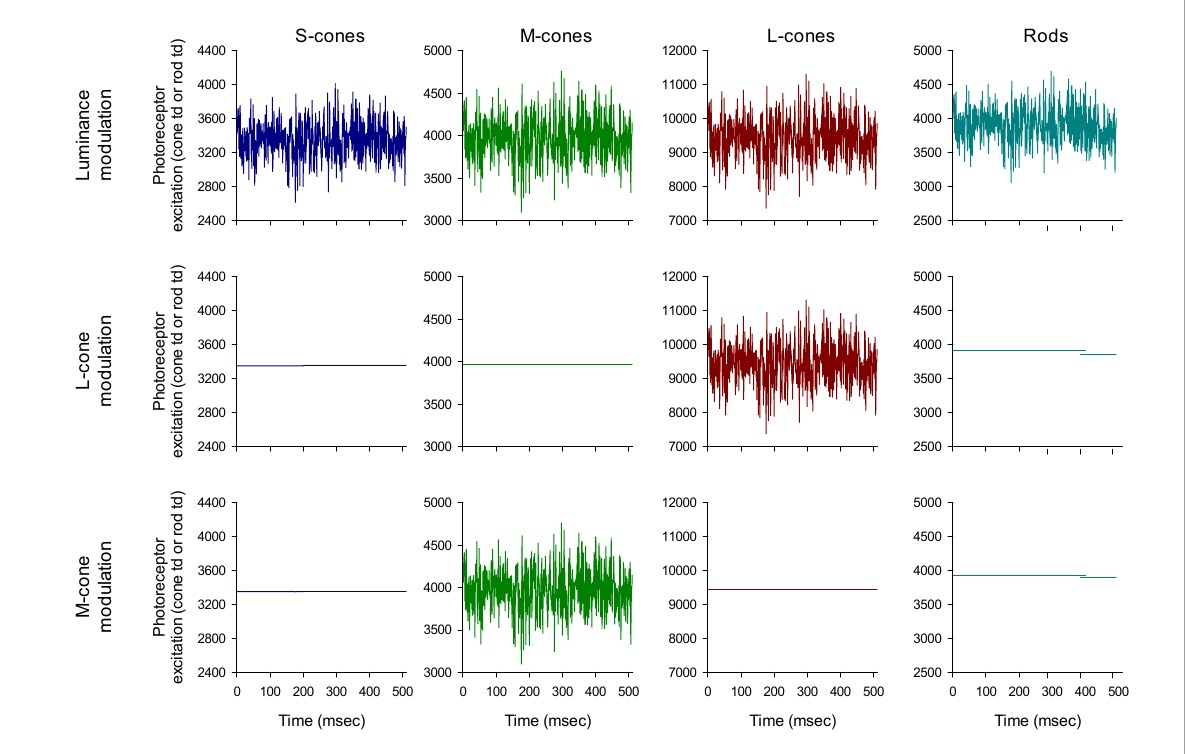
FIGURE3 Validation of the stimulus conditions. The upper row shows that the four photoreceptor types modulate with equal temporal (white noise) profiles. The photoreceptor Michelson contrasts (defined as the difference between the maximal and the minimal excitation divided by twice the mean excitation) are equal for all photoreceptor types (22%). The middle row shows that only the L-cone excitation is modulated with a TWN profile in the L-cone isolating condition. The profile also equals the L-cone profile in the first row (luminance conditions) showing that the L-cone contrast is 22%. Similarly, the third row shows the M-cone temporal profile and the comparison with the profile in the luminance condition shows that the M-cone contrast is 22%.